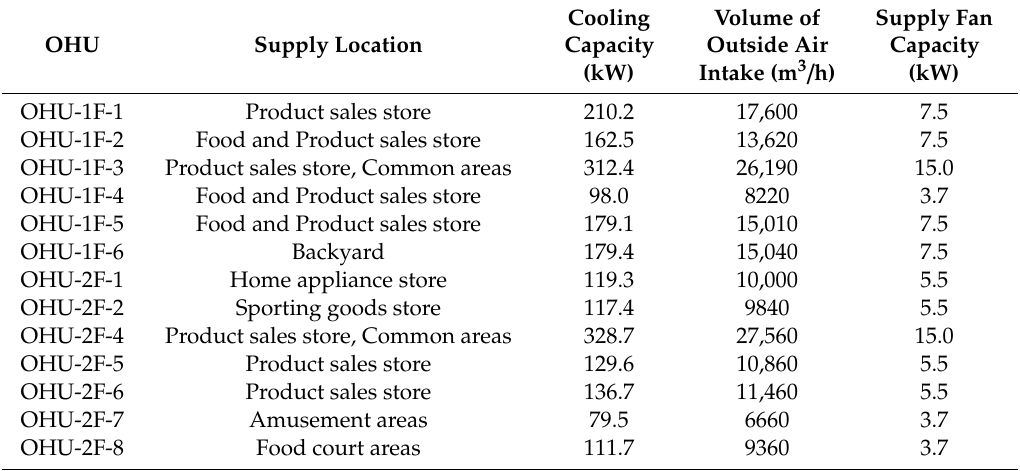
Table 3. Specifications of outside-air processing units targeted for automatic energy-saving